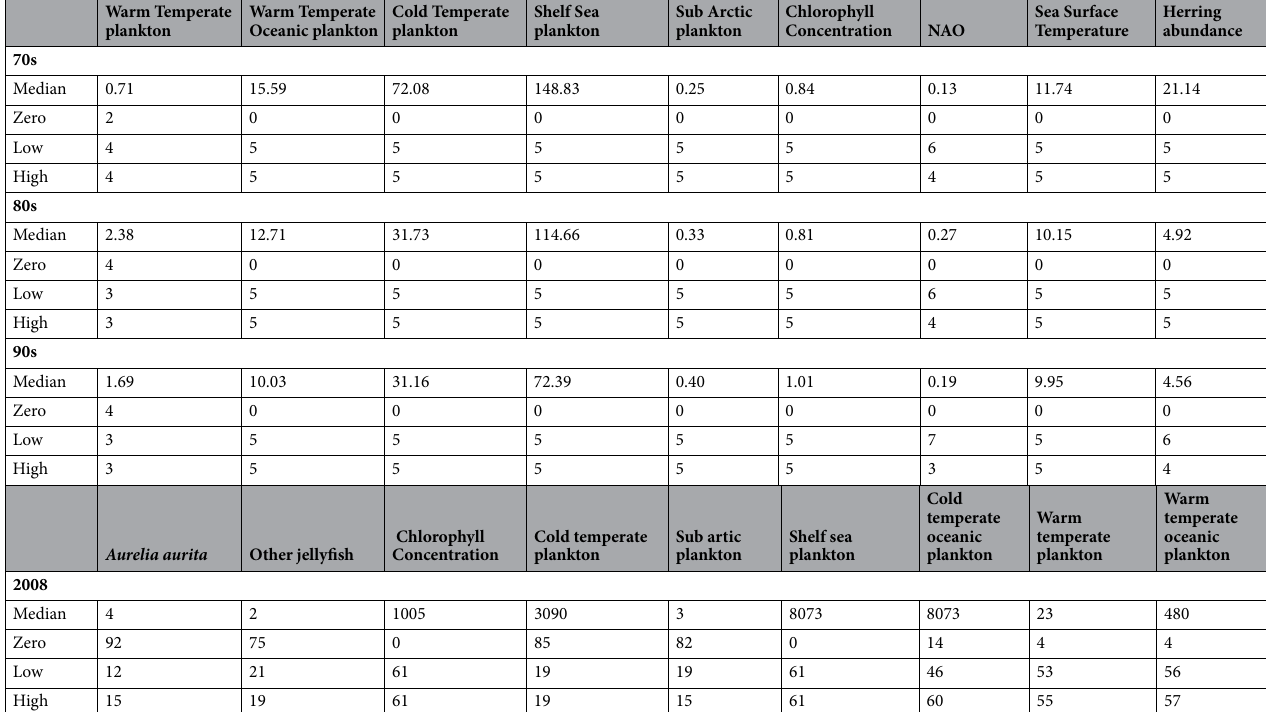
Table 2. Zooplankton count data for the different variables included in the Bayesian network inference. Median is the median count numbers for each variable which defines the break between the High and Low